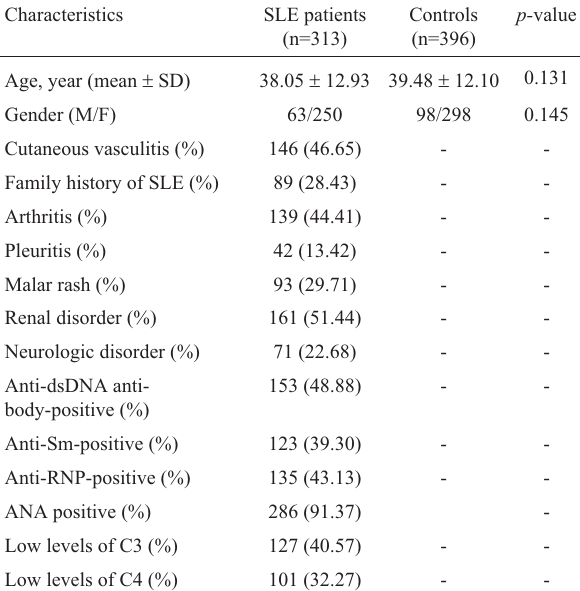
Table 1 - Clinical characteristics of the